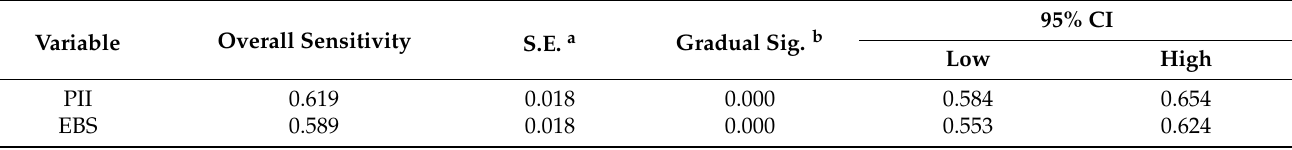
Figure 9. Diagnostic analysis of consumers’ ITPP to EBS and PII changes. Table 7. Test results for diagnostic analysis.